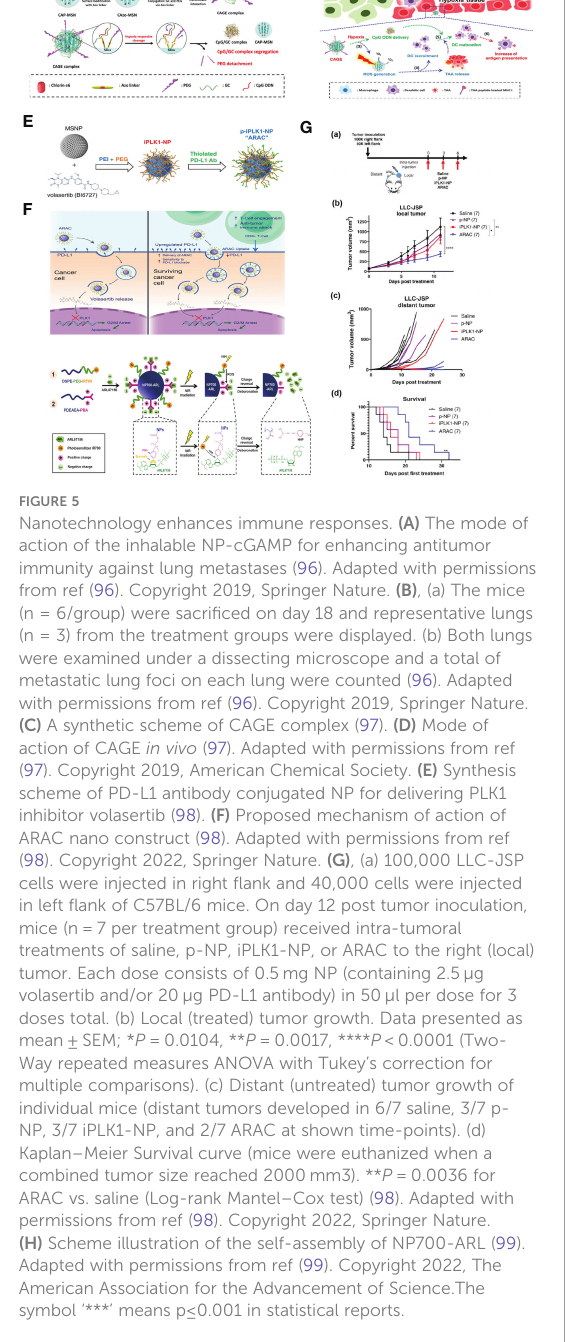
NP, 3/7 iPLK1-NP, and 2/7 ARAC at shown time-points). (d) Kaplan – Meier Survival curve (mice were euthanized when a combined tumor size reached 2000mm3). ** P =0.0036 for ARAC vs. saline (Log-rank Mantel – Cox test) (98). Adapted with permissions from ref (98). Copyright 2022, Springer Nature. (H) Scheme illustration of the self-assembly of NP700-ARL (99). Adapted with permissions from ref (99). Copyright 2022, The American Association for the Advancement of Science.The symbol ‘ *** ’ means p ≤ 0.001 in statistical